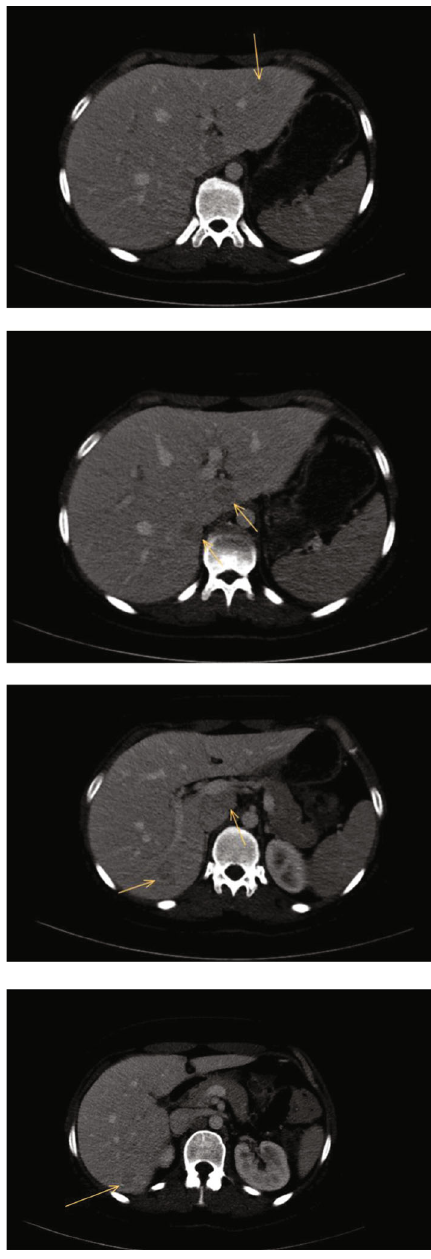
Figure 3: Liver CT demonstrated the onset of seven liver lesions suspect for metastatic disease.